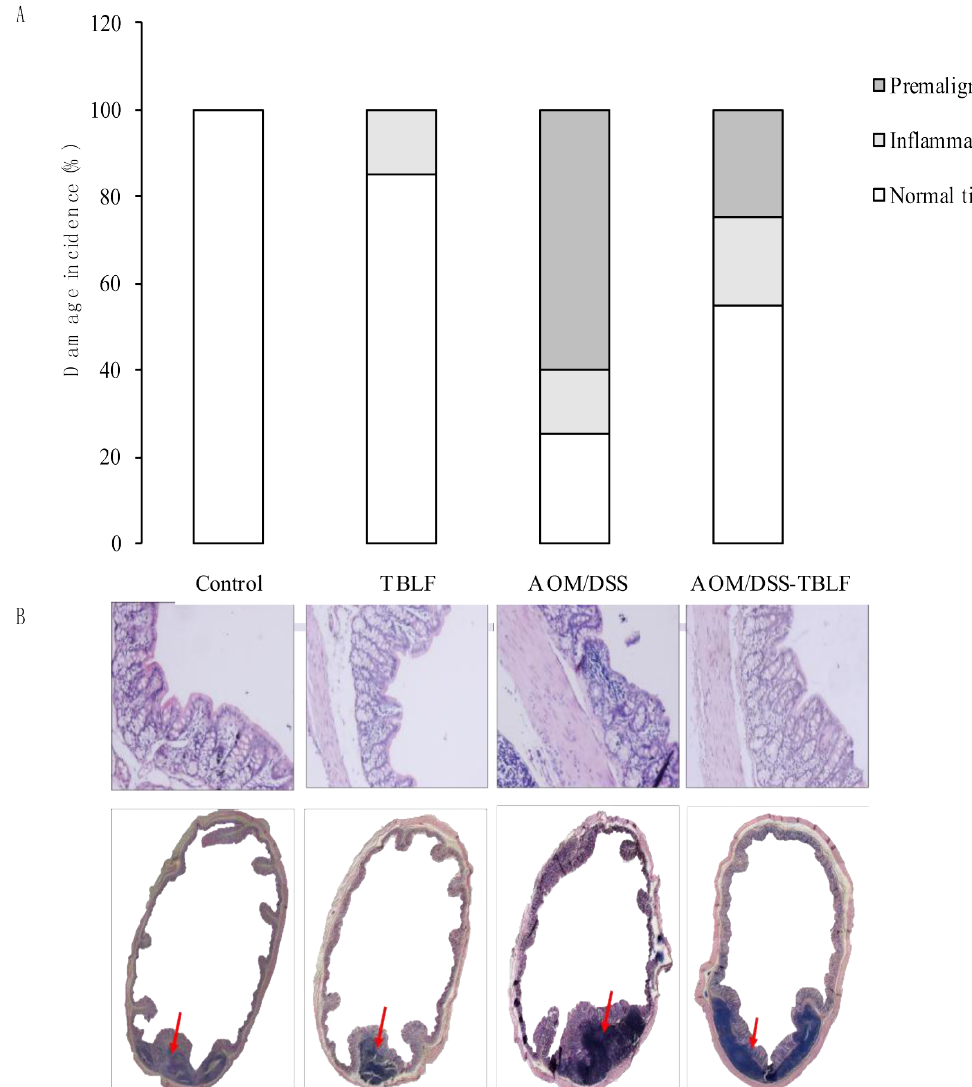
Figure 6. Histopathological analyses for colon lesions provoked by AOM/DSS and treated with TBLF. Rats were intraperitoneally administered for two weeks with AOM and a further two weeks with DSS in their daily drinking water to develop ACF. Next, they were administered with TBLF (50 mg/kg) on alternate days for six weeks via intra-gastric cannula. ( A ) Incidence of aberrant cryptic foci; ( B ) Hematoxylin-eosin histopathological analyses of colon lesions (10 × ). Red arrows show lymphocyte infiltration. Although no tumors were observed, AOM/DSS treatment showed a high disruption process that was diminished by